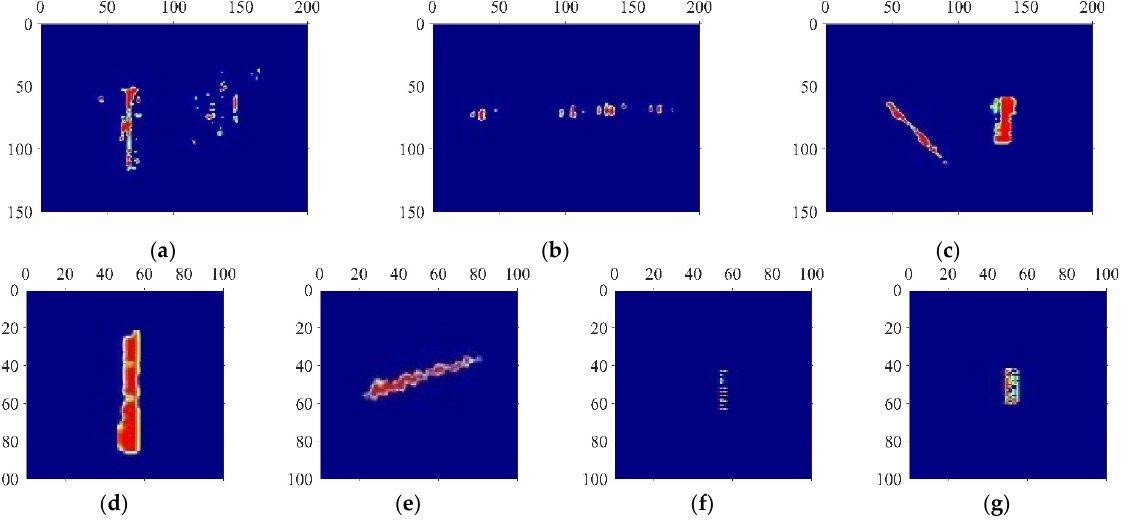
Figure 4. Data images of vibration events after pseudo-color processing: ( a ) Natural wind; ( b ) HSR passing by; ( c ) Walking and climbing over fence simultaneously; ( d ) Climbing over fence; ( e ) Walking near fence; ( f ) Manual excavation; ( g ) Construction machinery.